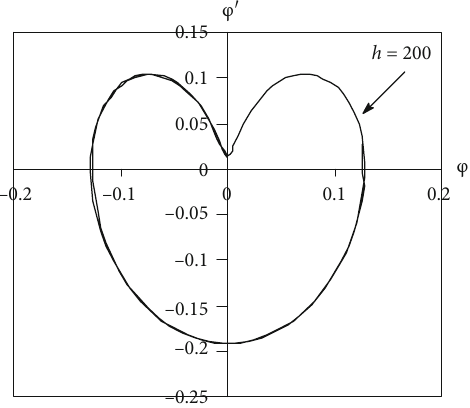
Figure 10: The analytical and numerical stabilities φ ′ against φ at h = 200 .